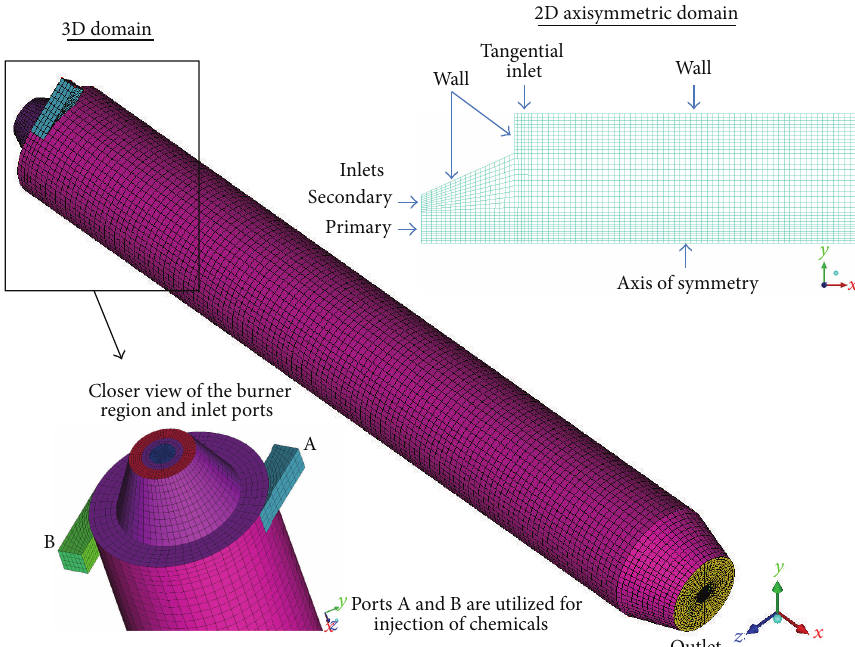
Figure 1: CFD computational domain for the VHTER reactor design.